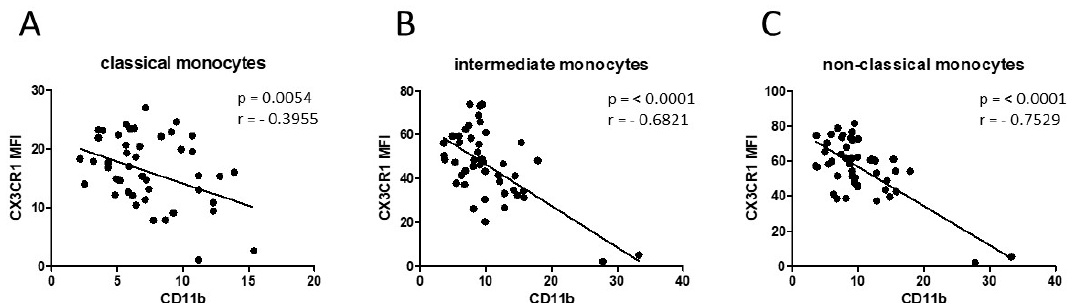
Figure 4. Correlation analysis between monocytic CD11b and CX3CR1 expression of HNSCC pa-